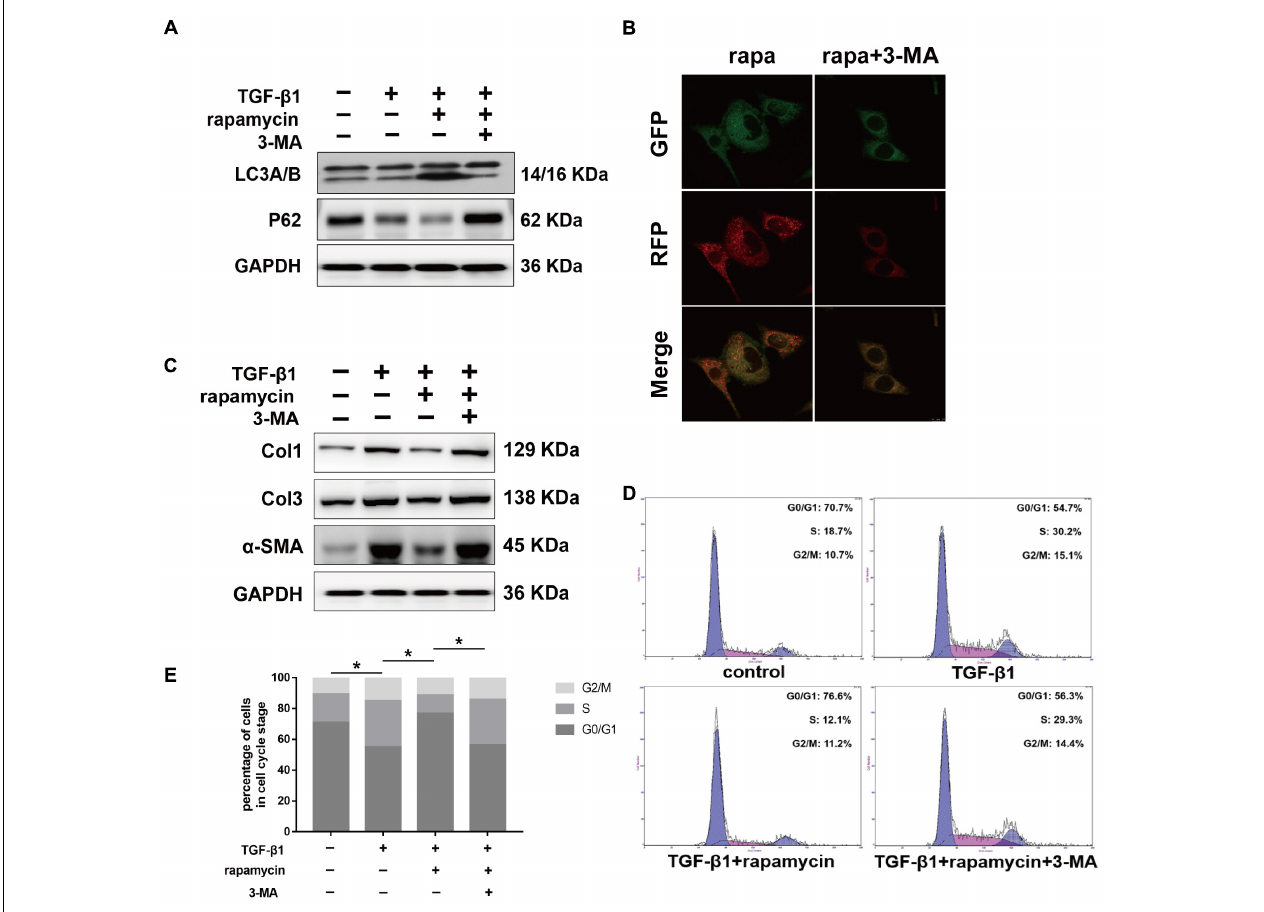
FIGURE 10 | Autophagy inhibitor 3-MA abolishes the protective effects of rapamycin in fibroblasts. Fibroblasts were pretreated with 3-MA (2 mM) for 2 h before further treatments. (A) Representative images of western blot analysis of LC3A/B and p62 after different treatments. (B) Representative images of fibroblasts stably transfected with GFP-RFP-LC3 were treated with 3-MA and rapamycin. (C) Representative images of western blot analysis of Col1, Col3, and α -SMA after different treatments. (D) Representative images of flow cytometry and (E) quantitative analysis of cell cycle distribution after different treatments. The data are shown as the means ± SD of three independent experiments. ∗ P <